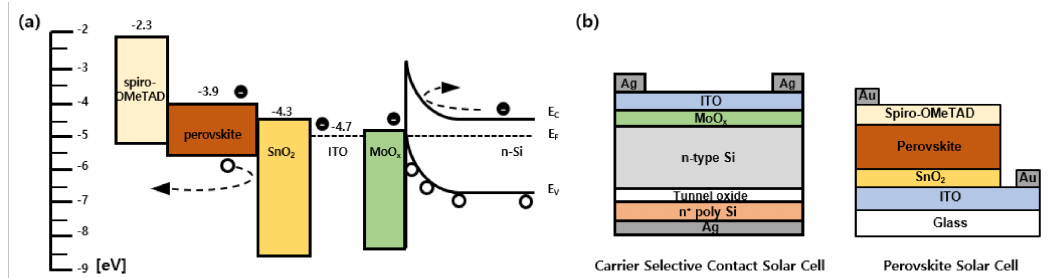
Figure 1. ( a ) Energy band diagram of the monolithic perovskite-carrier selective contact silicon tandem solar cell using MoO x . ( b ) Schematic diagrams of the carrier selective contact solar cell and the perovskite solar